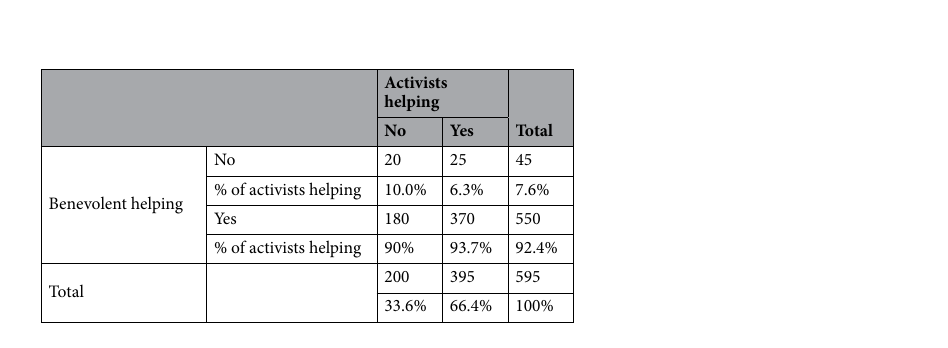
Table 2. Contingency table showing the relationship between benevolent (in columns) and activist (in rows) types of